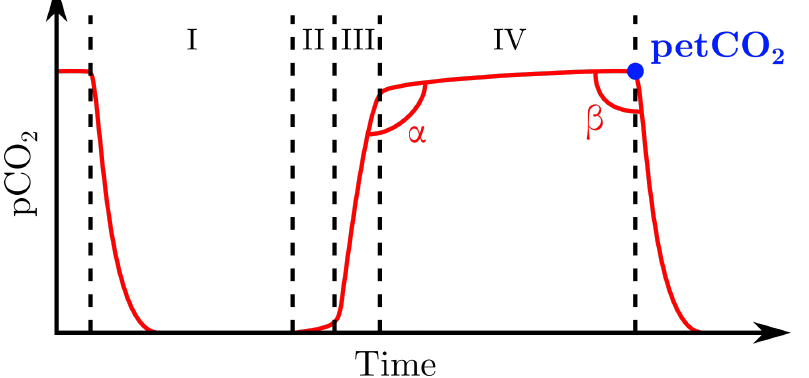
Figure 13. A capnogram yields important clinical clues on the state of the patient or quality of their intubation by analysing the different breathing phases—inspiration (I), and expiration: dead- space volume (II), mixed dead-space and alveolar air (III) and alveolar air (IV)—and the two α and β angles [292,293]. More narrowly, capnometry is only interested in knowing the more concise end-tidal pCO 2 value reached at the end of the plateau (IV): petCO 2